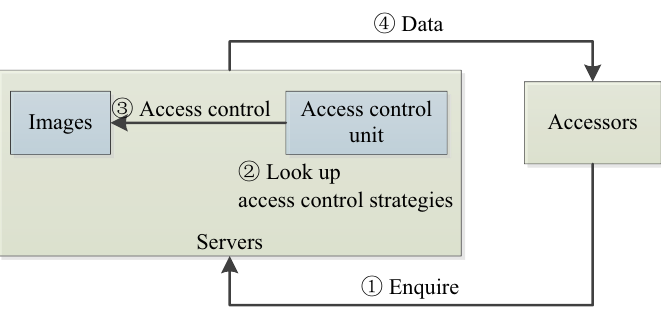
Figure 1. Existing traditional access control model.